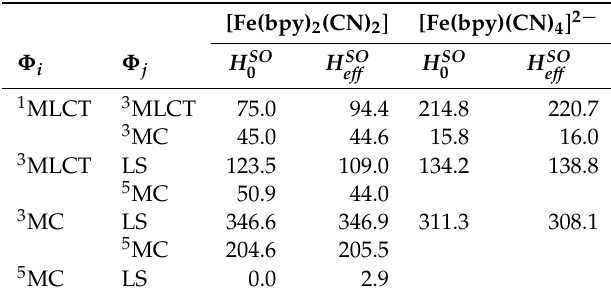
Table 3. Direct and effective (maximum) spin orbit matrix elements between Φ i and Φ j